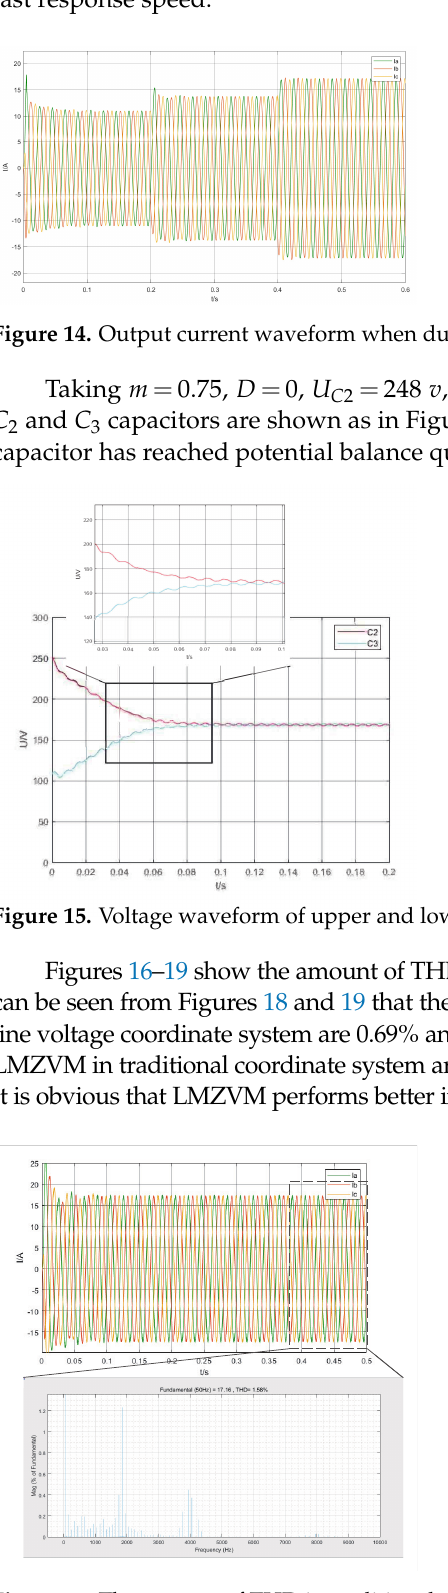
Figure 16. The amount of THD in traditional coordinate when m = 0.75, D =